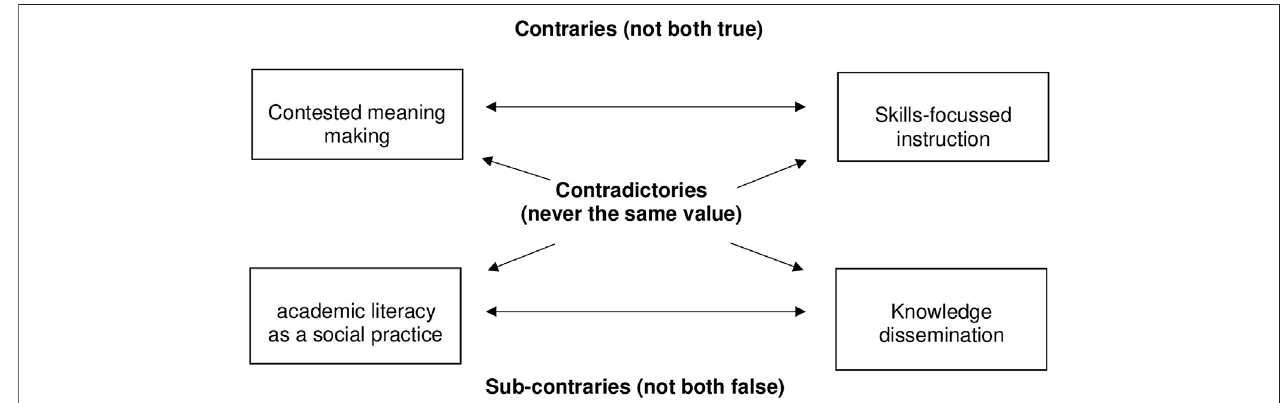
FIGURE 2 | Square of opposition: academic literacy